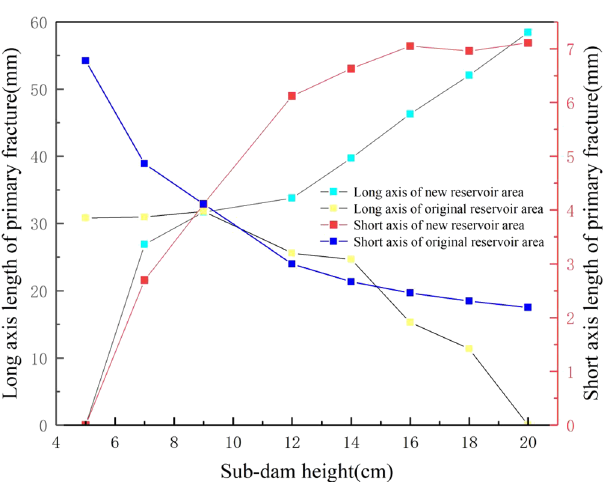
Figure 8. Accumulation height of the new reservoir area and geometric characteristics of primary fractures in the new and original reservoir